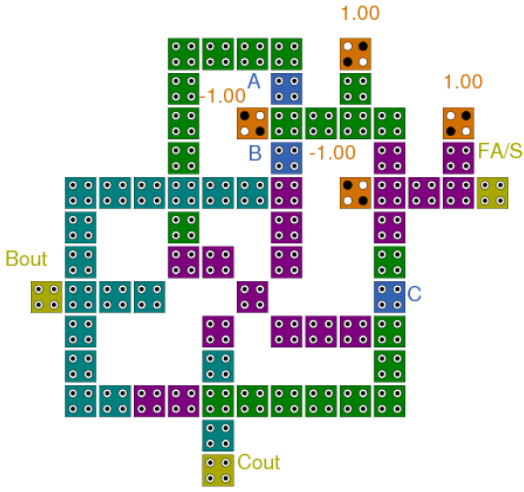
Figure 15. The proposed (B) Full Adder/Full Subtractor circuit.